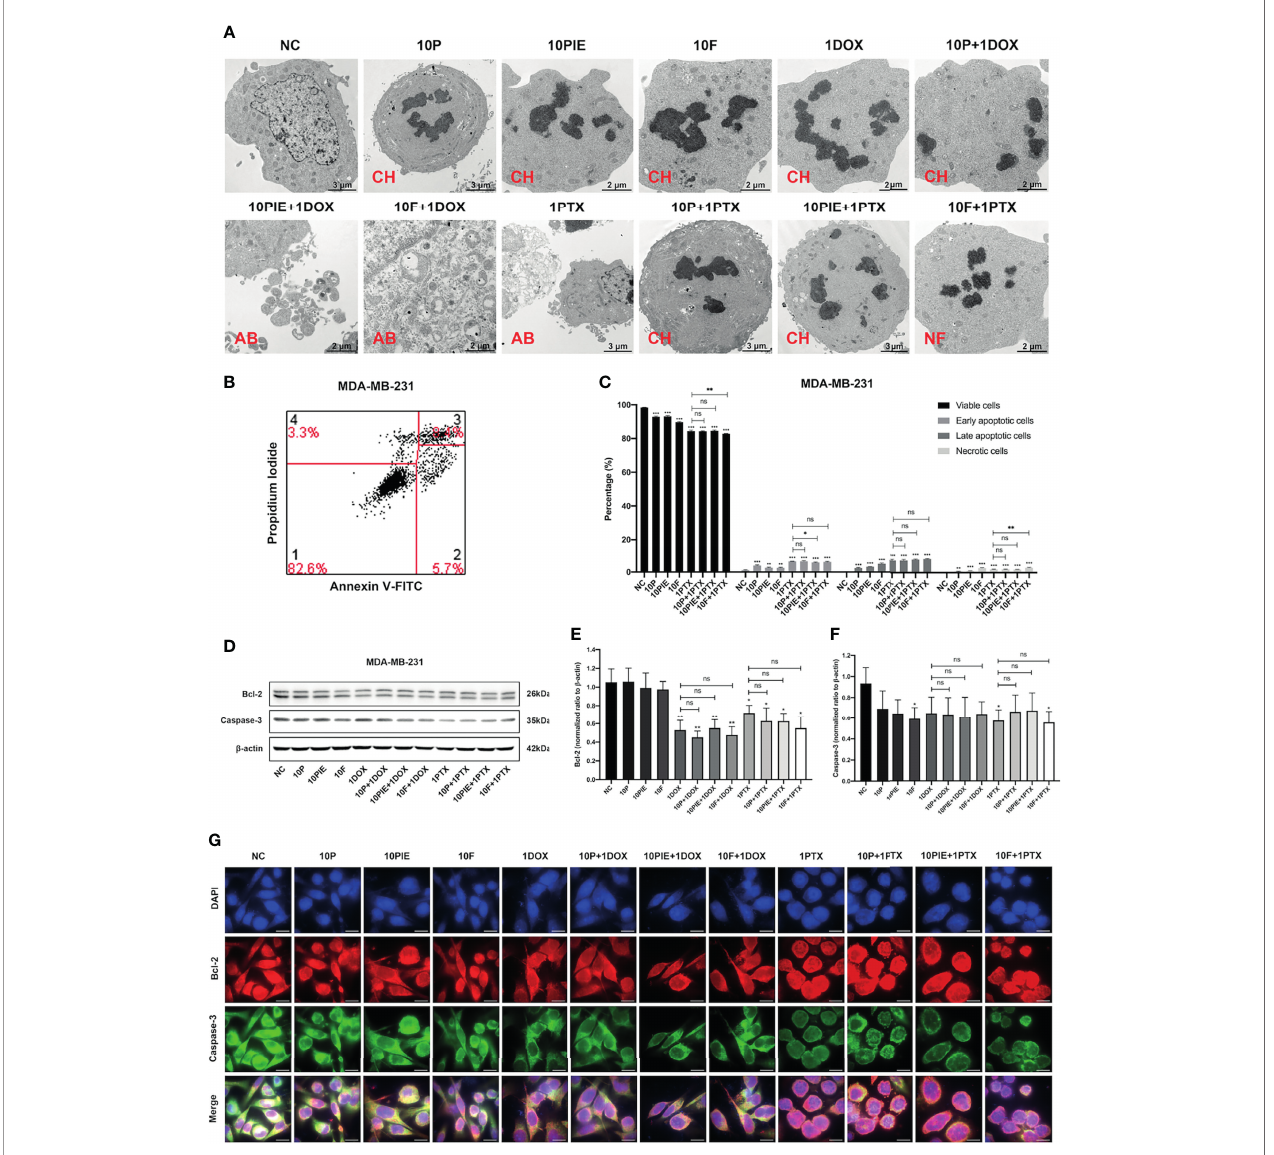
FIGURE 2 | Apoptosis analyses of MDA-MB-231 cells exposed to propofol/PIE/fospropofol disodium with or without doxorubicin/paclitaxel. (A) Apoptotic morphological changes of MDA-MB-231 cells treated with different drugs, observed via TEM. CH, chromatin condensation; AB, apoptotic bodies; NF, nucleus fragmentation. (B) Gating strategy for cell apoptosis assessment. Representative plots were obtained from MDA-MB-231 cells administered fospropofol disodium (10 µg/ml) plus paclitaxel (1 µg/ml). (C) Percentage of viable, early and late apoptotic, and necrotic MDA-MB-231 cells exposed to propofol/PIE/fospropofol disodium with or without paclitaxel. (D) The expression level of Bcl-2 and caspase-3 in MDA-MB-231 cells under treatment with different drugs was determined by western blotting. b -actin was used as the internal reference. (E, F) The statistical analyses of western blotting bands of Bcl-2 and caspase-3. Each experiment was repeated at least three times. (G) The expression and subcellular localization of Bcl-2 and caspase-3 in MDA-MB-231 cells after different drug treatments was determined by mIHC. DAPI was used to stain cell nuclei. Bar = 14 µm. NC, normal control; 10P, 10 µg/ml propofol; 10PIE, 10 µg/ml propofol injectable emulsion; 10F, 10 µg/ml fospropofol disodium; 1DOX, 1 µg/ml doxorubicin; 10P+1DOX, 10 µg/ml propofol combined with 1 µg/ml doxorubicin; 10PIE+1DOX, 10 µg/ml PIE combined with 1 µg/ml doxorubicin; 10F+1DOX, 10 µg/ml fospropofol disodium combined with 1 µg/ml doxorubicin; 1PTX, 1 µg/ml paclitaxel; 10P+1PTX, 10 µg/ml propofol combined with 1 µg/ml paclitaxel; 10PIE+1PTX, 10 µg/ml PIE combined with 1 µg/ml paclitaxel; 10F +1PTX, 10 µg/ml fospropofol disodium combined with 1 µg/ml paclitaxel. ns, no signi fi cant difference. * P < 0.05, ** P < 0.01, *** P <